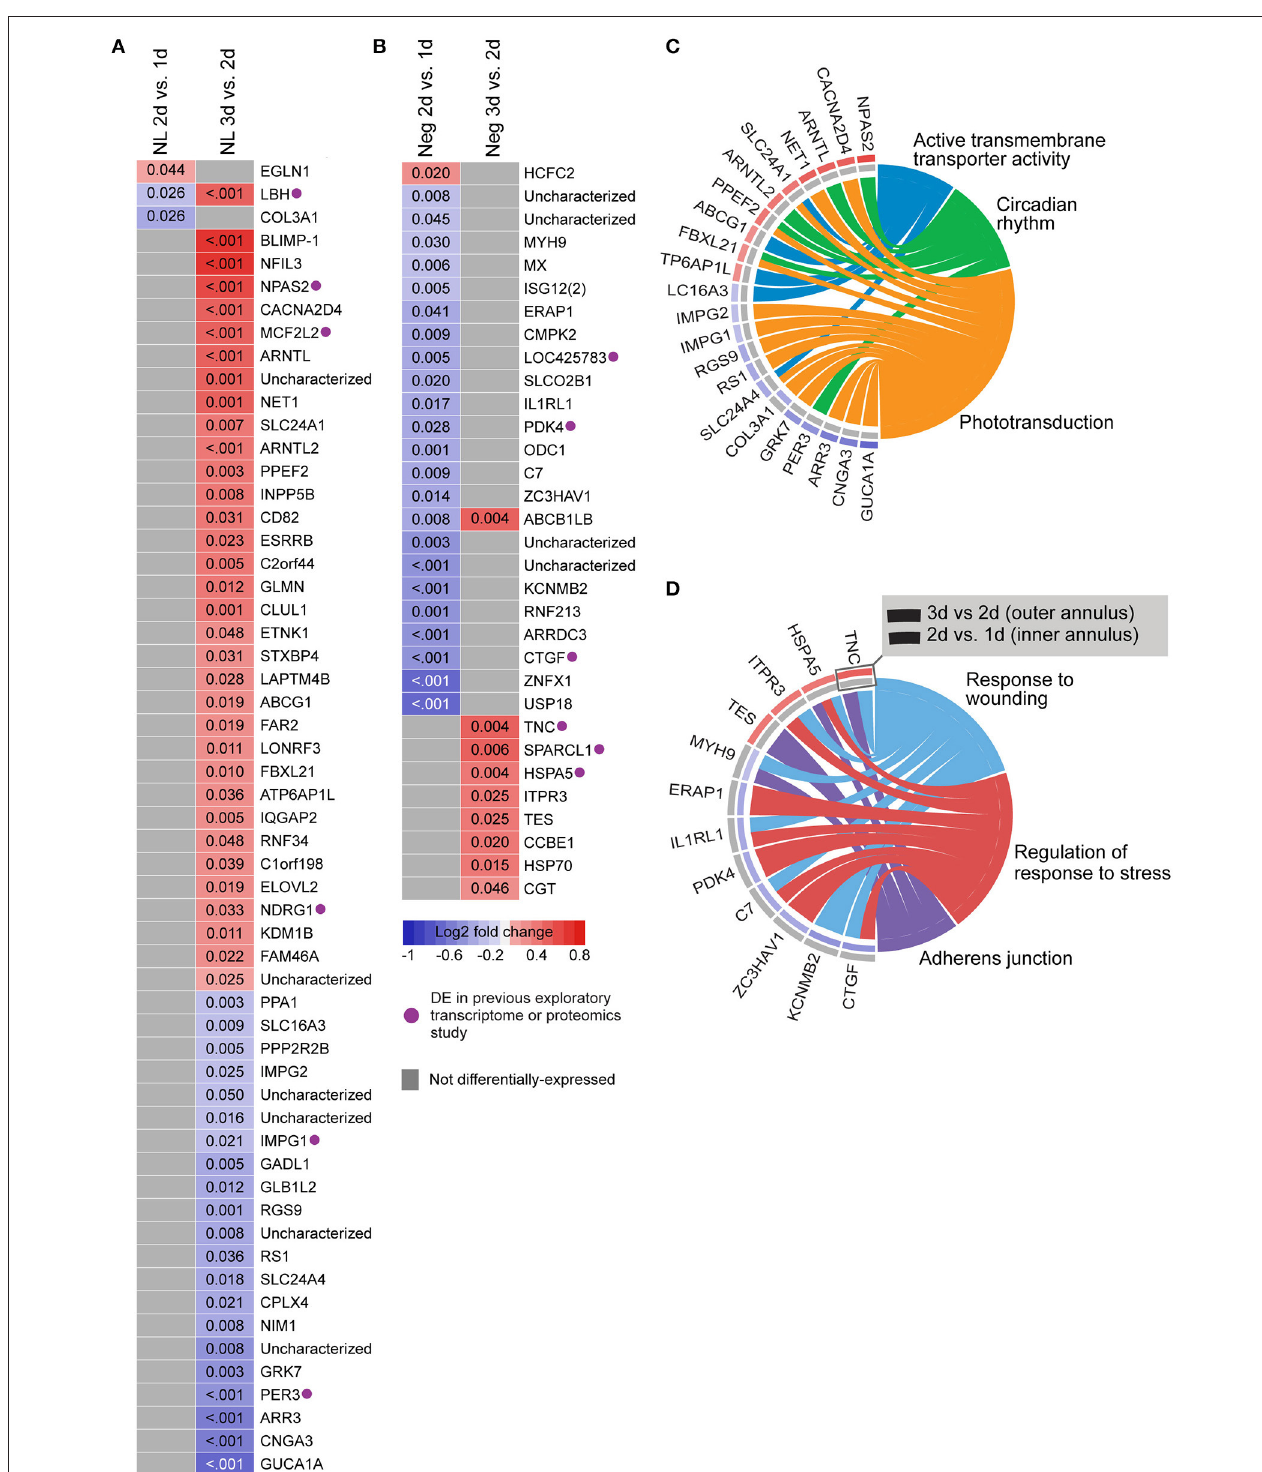
FIGURE 3 | Differential expression of single genes over time within No Lens and negative lens groups. (A) Heatmap showing genes differentially expressed between 1–2 and 2–3 days of normal No Lens development. (B) Heatmap showing genes differentially expressed between 1–2 and 2–3 days of negative lens induced myopia induction. Note that no genes were differentially-expressed over time during hyperopia induction. Fold change is indicated by grid color (red = up-regulation, blue = down-regulation, gray = not differentially-expressed), and Benjamini–Hochberg adjusted p -values are super-imposed on the grid. Purple symbols